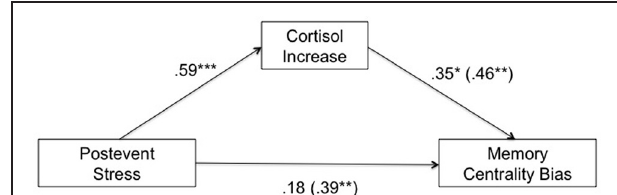
FIGURE 5 | Mediation analysis for the high thematic arousal condition, with post-event stress (control = − 1, stress = + 1) as independent variable, cortisol increase as mediator, and memory centrality bias (proportion of accepted central event items minus proportion of accepted peripheral event items) as dependent variable. Path coefficients are standardized β -coefficients from (multiple) regression analyses. The numbers in parentheses represent the direct effect (bivariate β -coefficients) of each of the two predictors (post-event stress and cortisol increase) prior to the inclusion of the other predictor. See text for the calculation of cortisol increase. ∗ p < 0 . 05, ∗∗ p < 0 . 01, ∗∗∗ p < 0 . 001